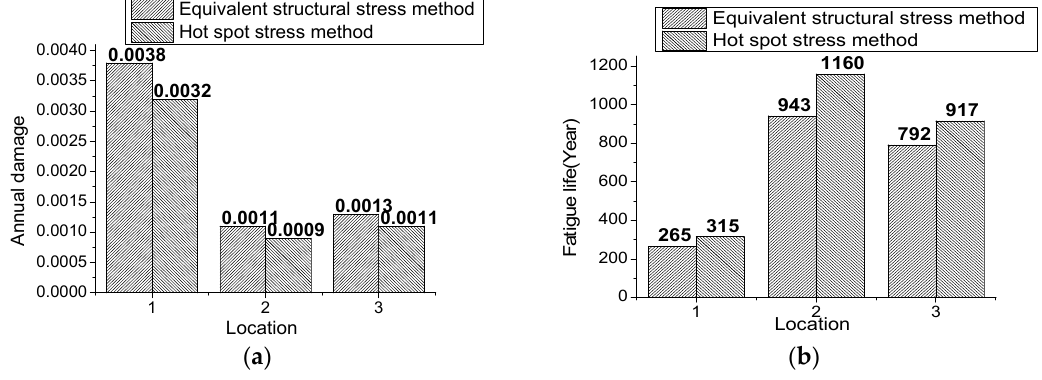
Figure 14. Comparison results of two methods: ( a ) Annual damage; and ( b ) Fatigue life.